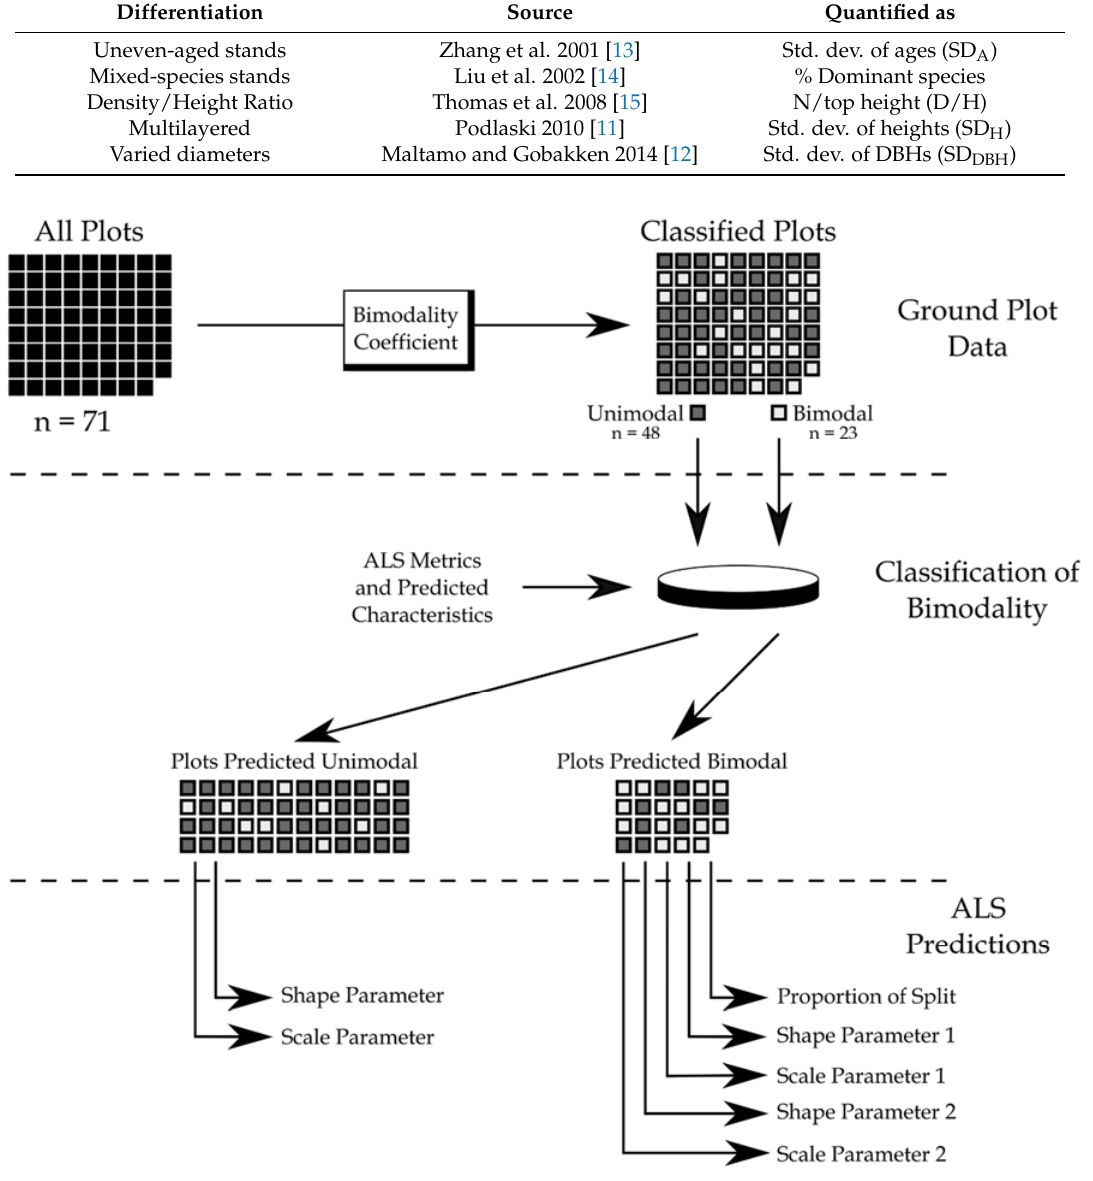
Figure 2. Workflow for differentiating bimodal plots and estimating stem size distribution (SSD) parameters with ALS. parameters with